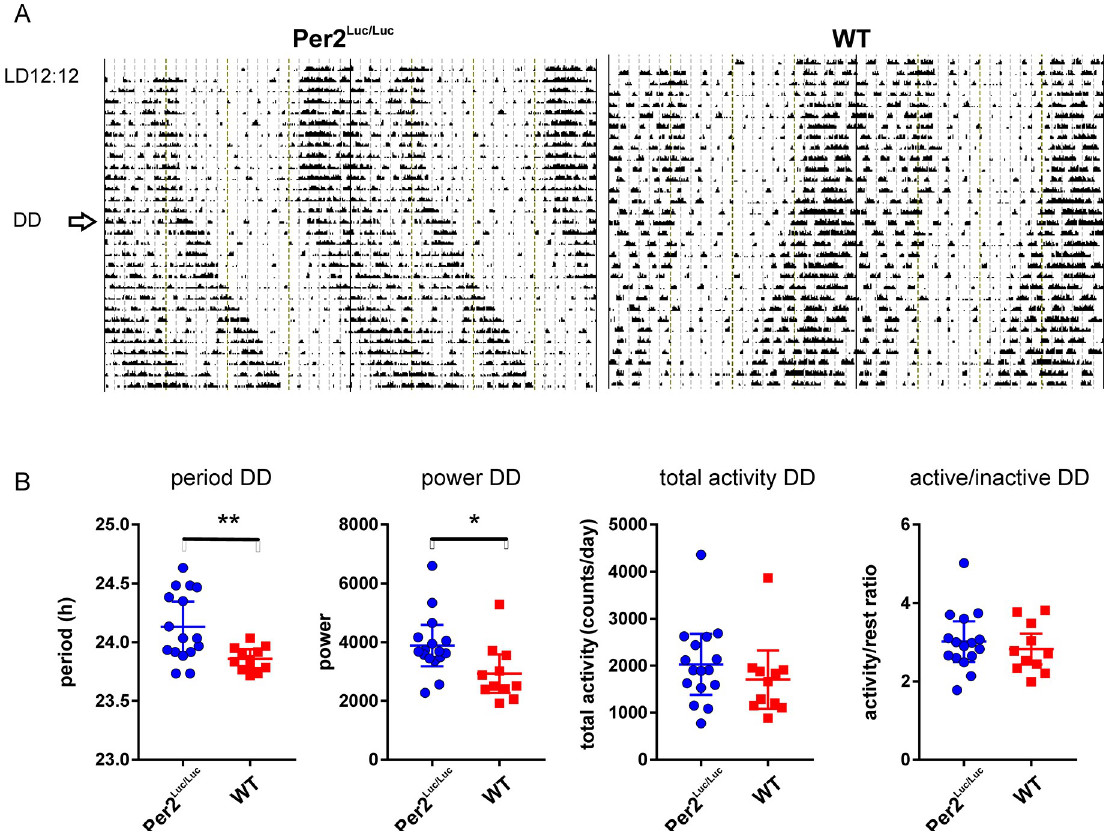
Fig 1. Genotype differences in OFA rhythms in DD. A . Representative activity records from one m Per2 uc/Luc and one WT C57Bl6 control animals maintained in LD and released into DD (arrow). B . Comparison of behavioral characteristics of m Per2 uc/Luc (n = 16) and WT (n = 11) in DD. Significantly longer period and power of the mPer2 Luc/Luc rhythms in DD. No difference in total amount of activity nor amplitude of the rhythm (activity/rest ratio). ( � P < 0.05; �� P < 0.01). Additional records are shown in S1A–S1C Fig